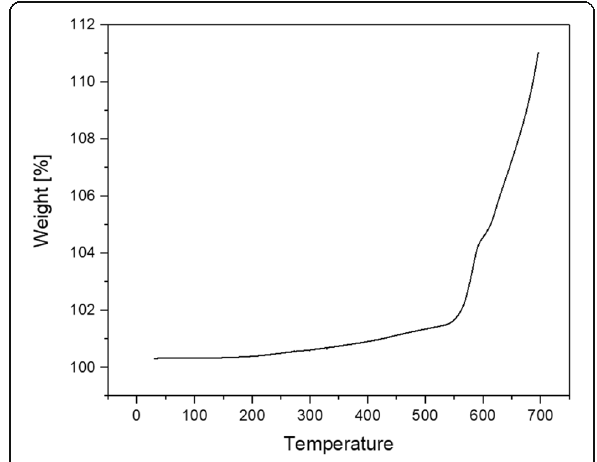
Fig. 4 TGA of NdFeB powder